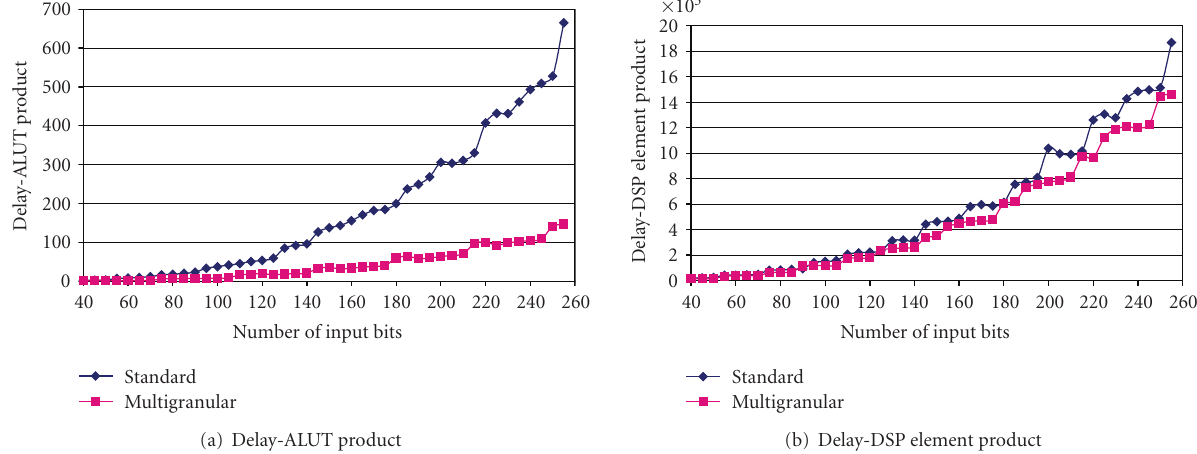
Figure 11: The Delay-ALUT product and the Delay-DSP element